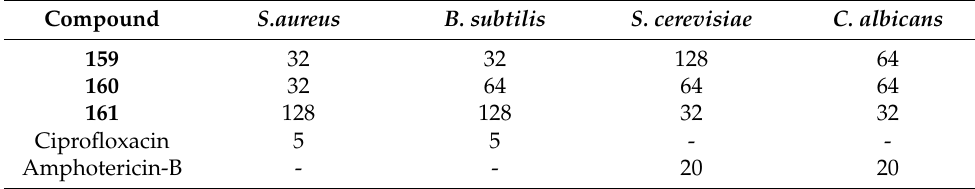
Table 10. Minimum inhibitory concentration (MIC) in µ g mL − 1 of compounds 159 – 161 . Compound